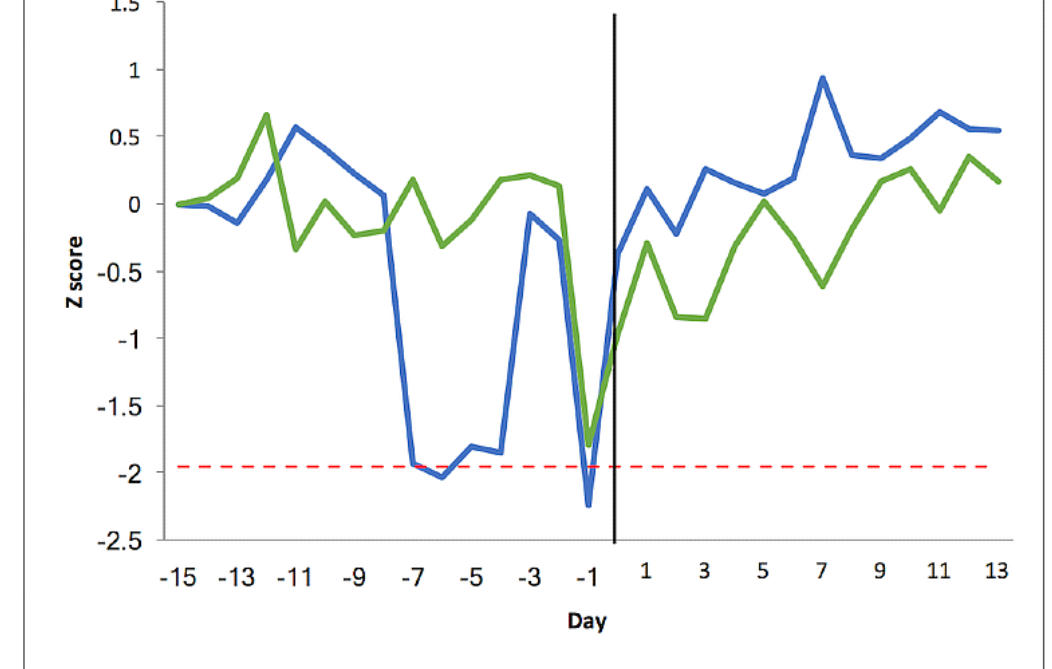
Figure 4. Oxygen saturation changes pre and post exacerbation for the 27 patients with chronic obstructive pulmonary disease. The y-axis represents the Z score relative to the patient’s baseline mean. The x-axis represents the time expressed in days. Day −15 is the mean of the stable period, days −14 to −1 is the preexacerbation period, day 0 is the day of initiation of treatment for exacerbation, and days 1 to 13 is the postexacerbation recovery. The red line represents the threshold limit of +1.96 SD. The once-daily group is represented by the green line and the overnight group by the blue